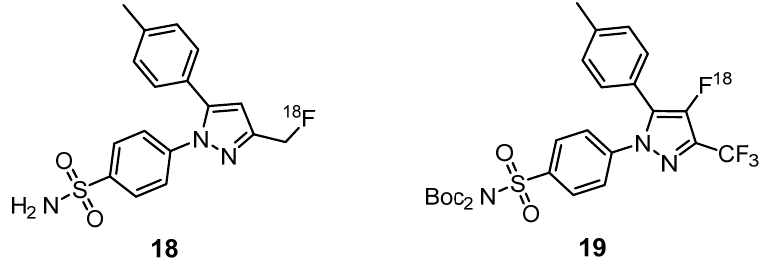
Figure 7. [ 18 F] ‐ labeled COX ‐ 2 inhibitors 18 and 19 [49,50].